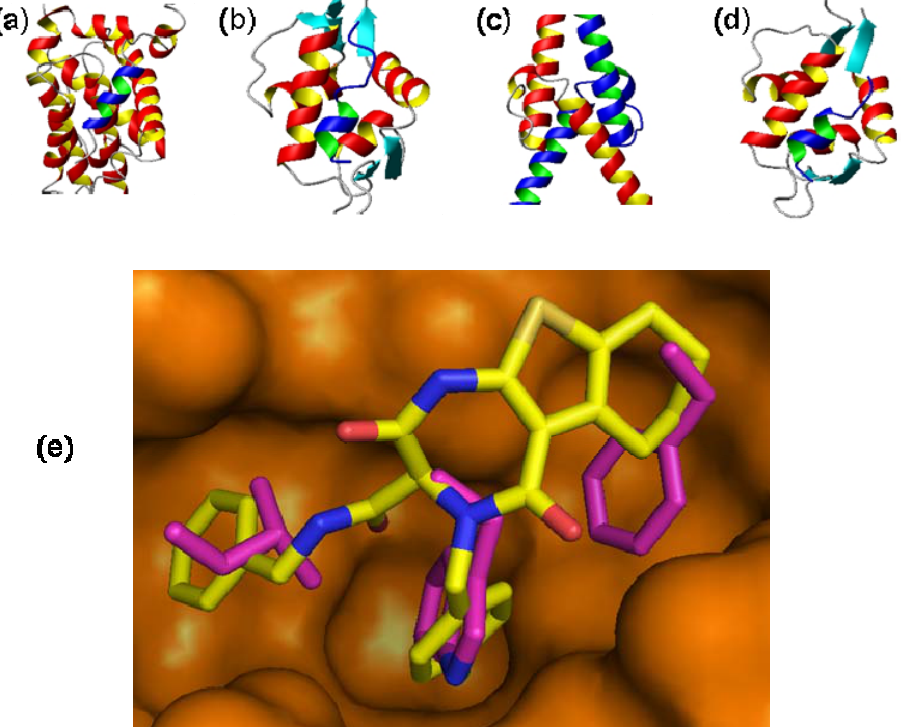
helical peptide (colored in blue/green) bound to Mdm2 (colored in red/yellow) (pdbid: 1YCR); ( c ) Structure of the basic/helix-loop-helix/leucine zipper (bHLHZ) domains of Myc (colored in red/yellow) and Max (colored in blue/green) heterodimers (pdbid: 1NKP); ( d ) Structure of a 15-residue transactivation domain peptide of human p53 (colored in blue/green) bound to the N-terminal domain of human Mdmx (colored in red/yellow) (pdbid: 3DAB). ( e ) Docking of an inhibitor of p53-Mdm2 interaction, developed from a small focused compound library of 1,4-thienodiazepine-2,5-diones, into the p53-binding site of Mdm2 (pdbid: 1YCR). The inhibitor (colored in yellow) is able to mimic hot spot residues (colored in purple) implicated in the p53-Mdm2 interface